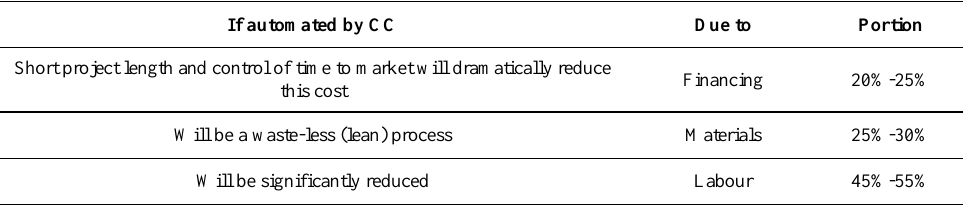
Portion Due to If automated by